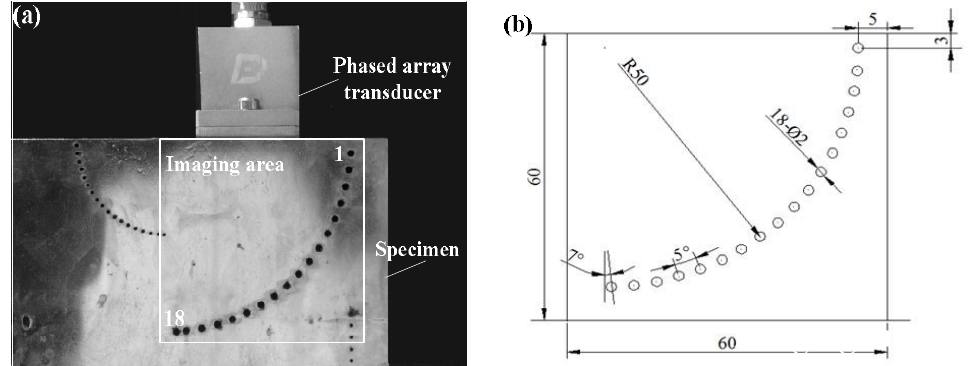
Figure 7. ( a ) Diagram of the experiment; ( b ) specimen in the ultrasonic phased array detection experiment.